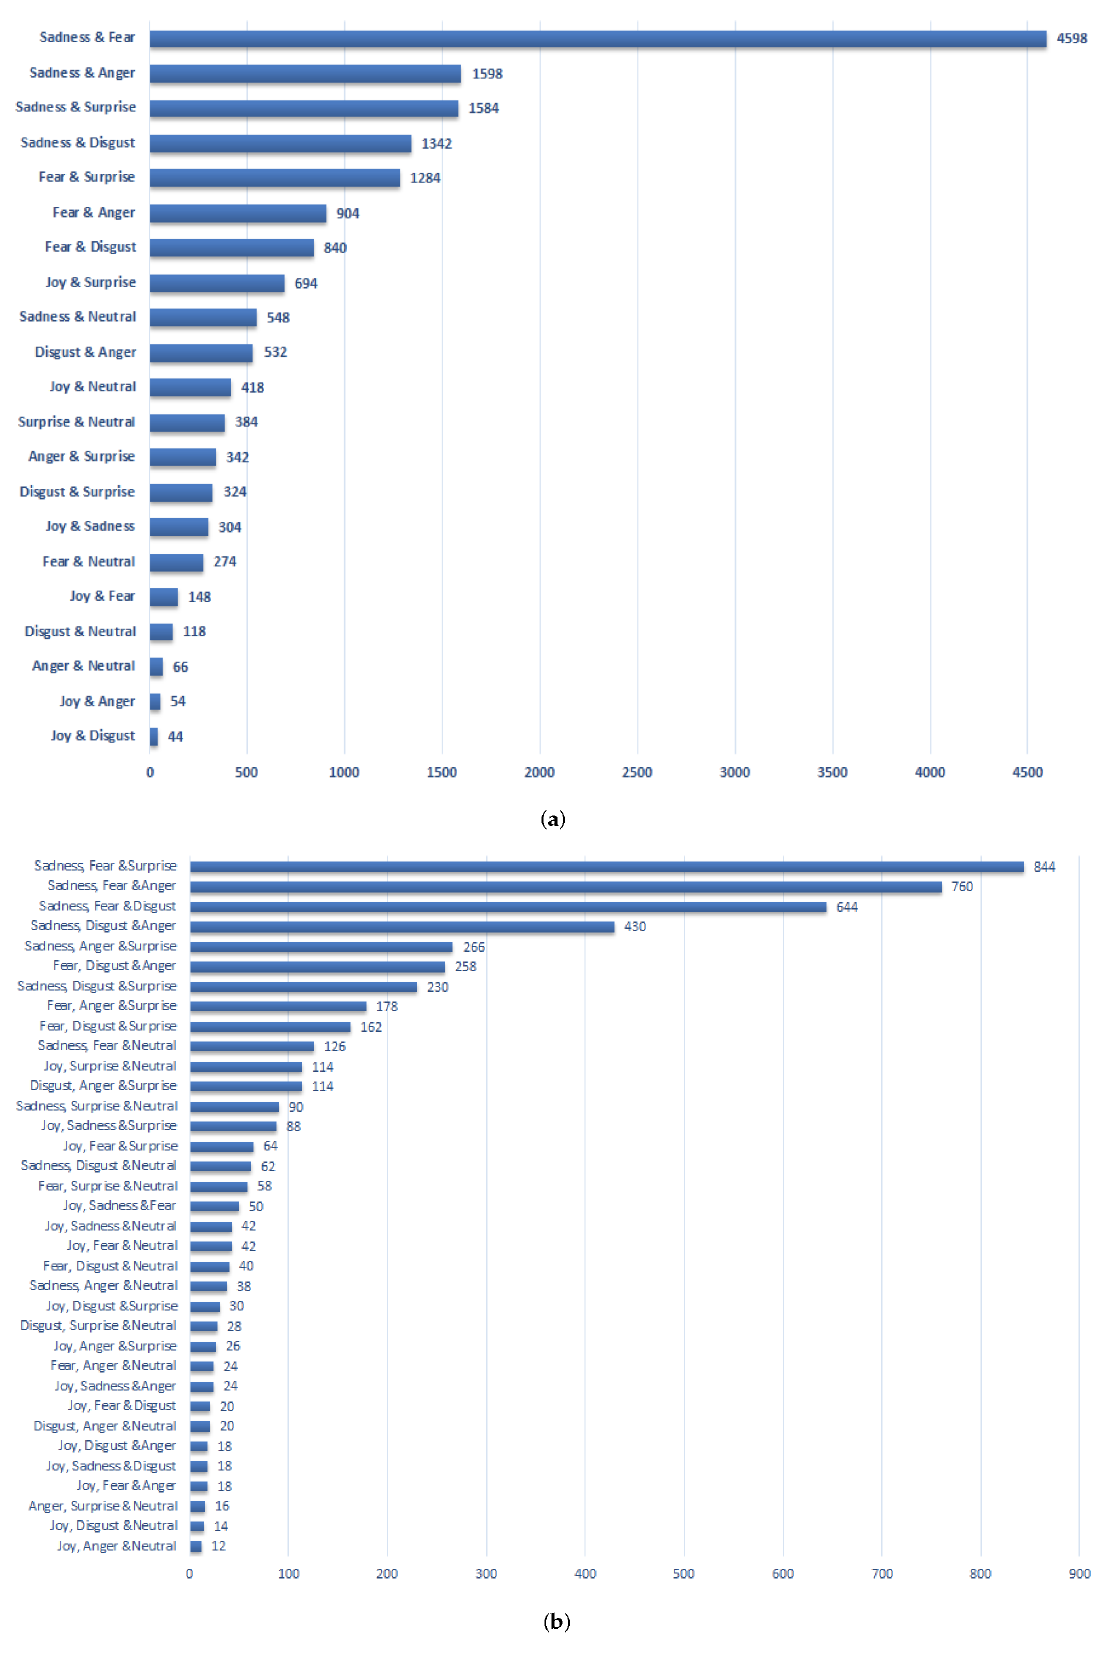
Figure 7. Statistics of the crowd-sourcing study in terms of how different tags are jointly associated with the images. ( a ) Tags jointly used in pairs. ( b ) Tags jointly used in a group of